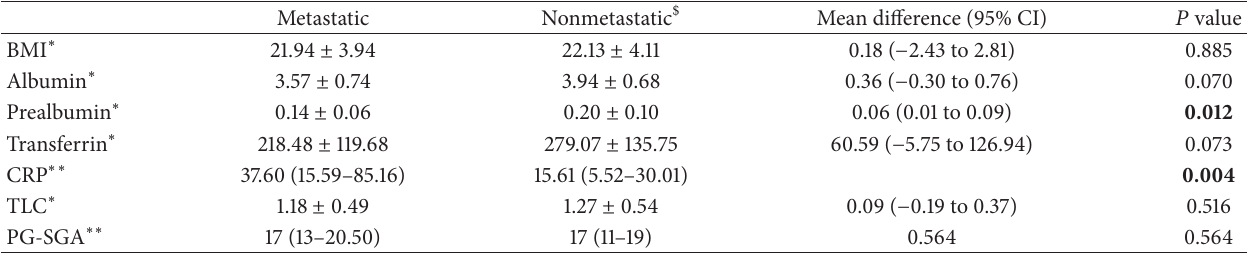
Table 3: Comparison between patients with metastatic and nonmetastatic inoperable gastric adenocarcinoma based on indicators of nutritional and inflammatory status.